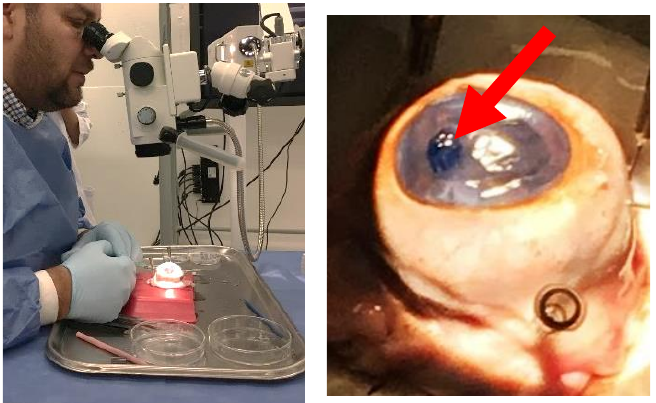
Figure 6. Ex vivo model for surgical manipulation test of collagen membranes. Manipulation of the model under the stereoscope ( left ). Membrane dyed with trypan blue transplanted into the de anterior chamber of the ex vivo model ( right ).